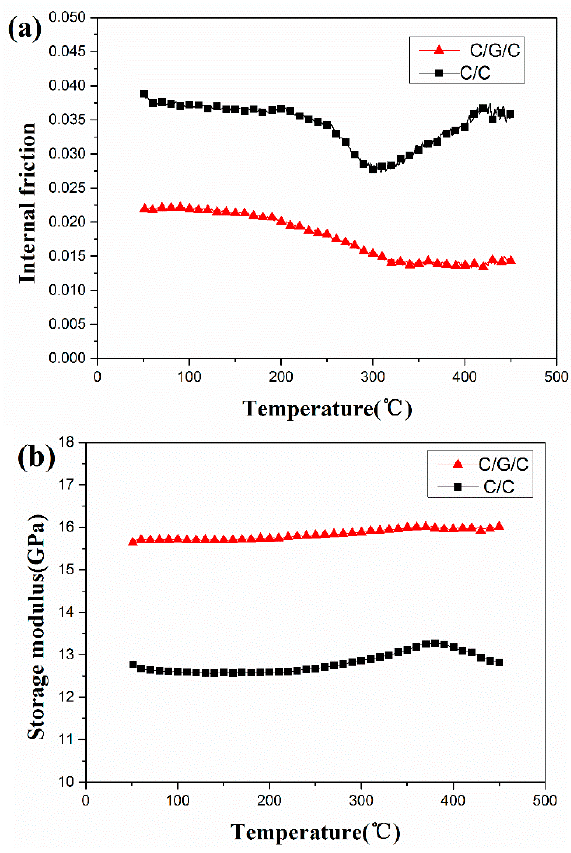
Figure 11. Dynamic mechanical properties of the composites versus temperature at 10 Hz and 0.025% strain: ( a ) internal friction; and ( b ) storage modulus.